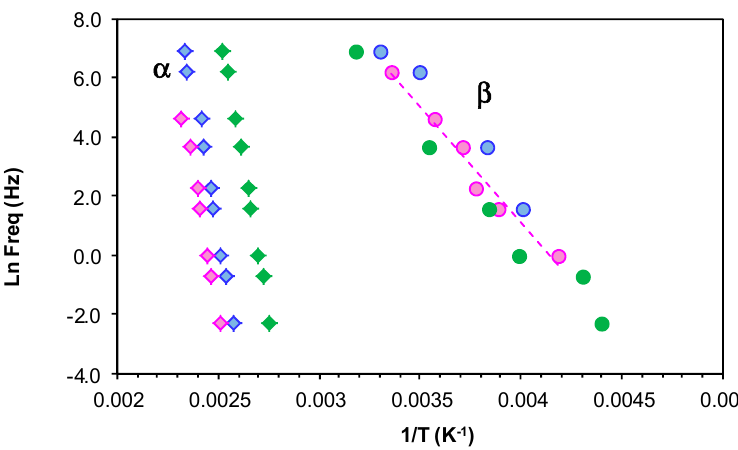
Figure 17. Relaxation map for the fully cured ELP800 (blue), ELP2000 (green), and ELP25000 (pink) systems obtained by DMA at 2 °C/min; α -relaxation, rhombus; β -relaxation, circles.